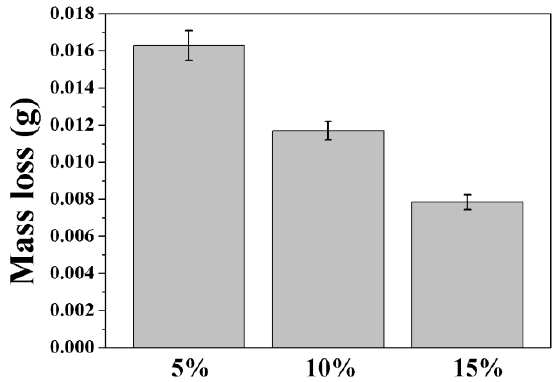
Figure 10. Mass loss of the NiCr–TiB 2 –ZrB 2 coatings.